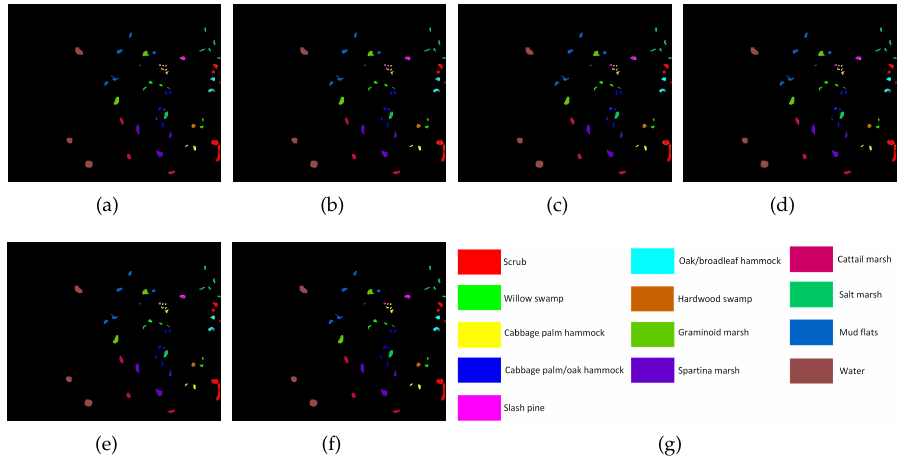
Figure 8. Classification maps for the Kennedy Space Center (KSC) data set obtained by different methods: ( a ) PCA; ( b ) ORF; ( c ) ORF-K-Means; ( d ) ORF-BIRCH; ( e ) PRF. In addition, ( f ) is the ground truth, and ( g ) is the legend.